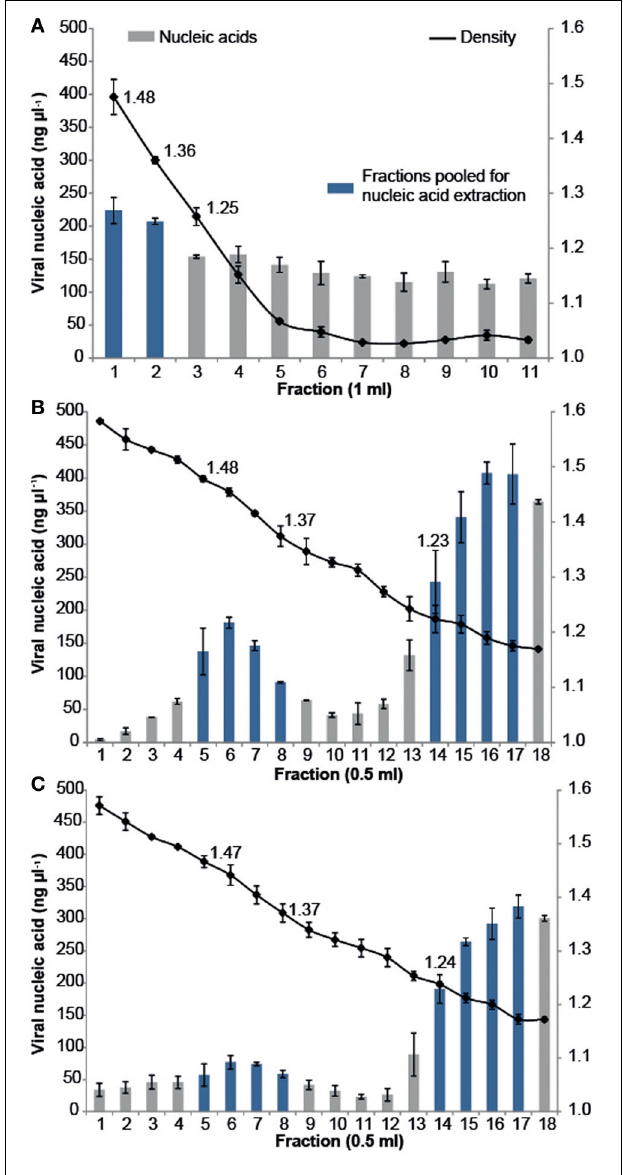
FIGURE 2 | Density and viral DNA concentrations for each fraction collected from step CsCl gradients of the virus fraction isolated from Pocillopora damicornis coral tissue using the (A) Chloroform (CFM) method without Liquid Nitrogen preservation of tissue (B) No Liquid Nitrogen (NLN) preservation of tissue and the MECH method (C) Liquid Nitrogen (LN2) preservation of tissue and the MECH method. Density fractions that were pooled and used for metagenomic sequencing are highlighted in